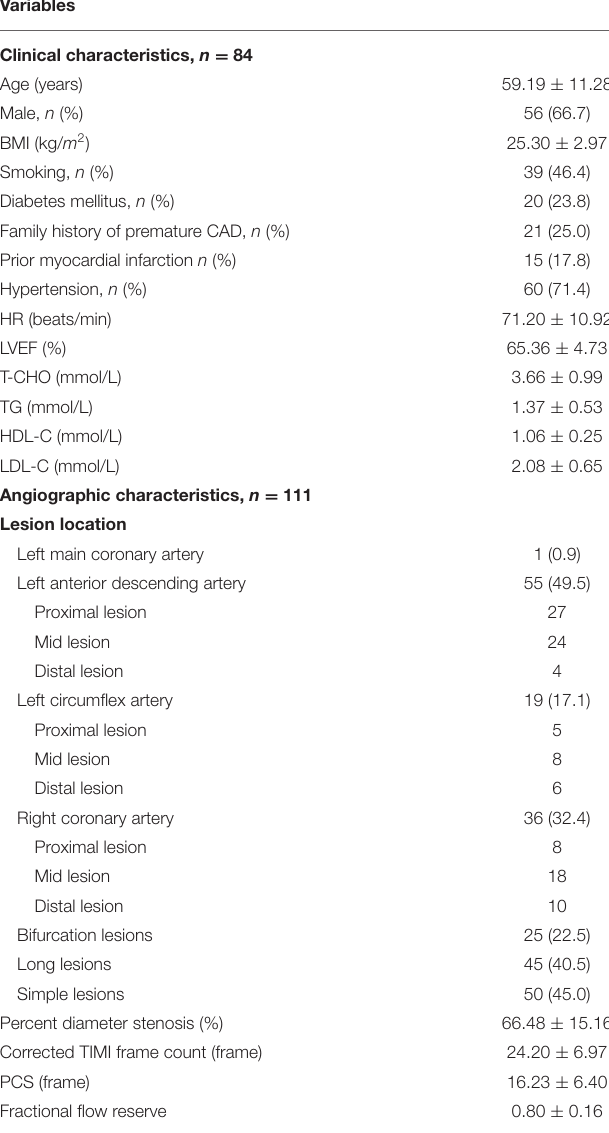
TABLE 1 | Demographic data and baseline characteristics of